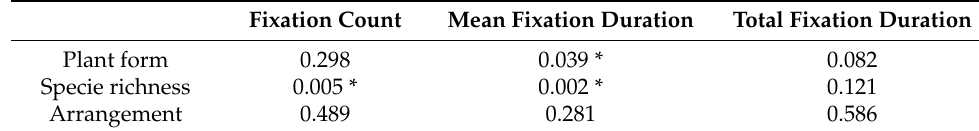
Table 2. Effects of ‘formal aesthetic’ factors on landscape perception.